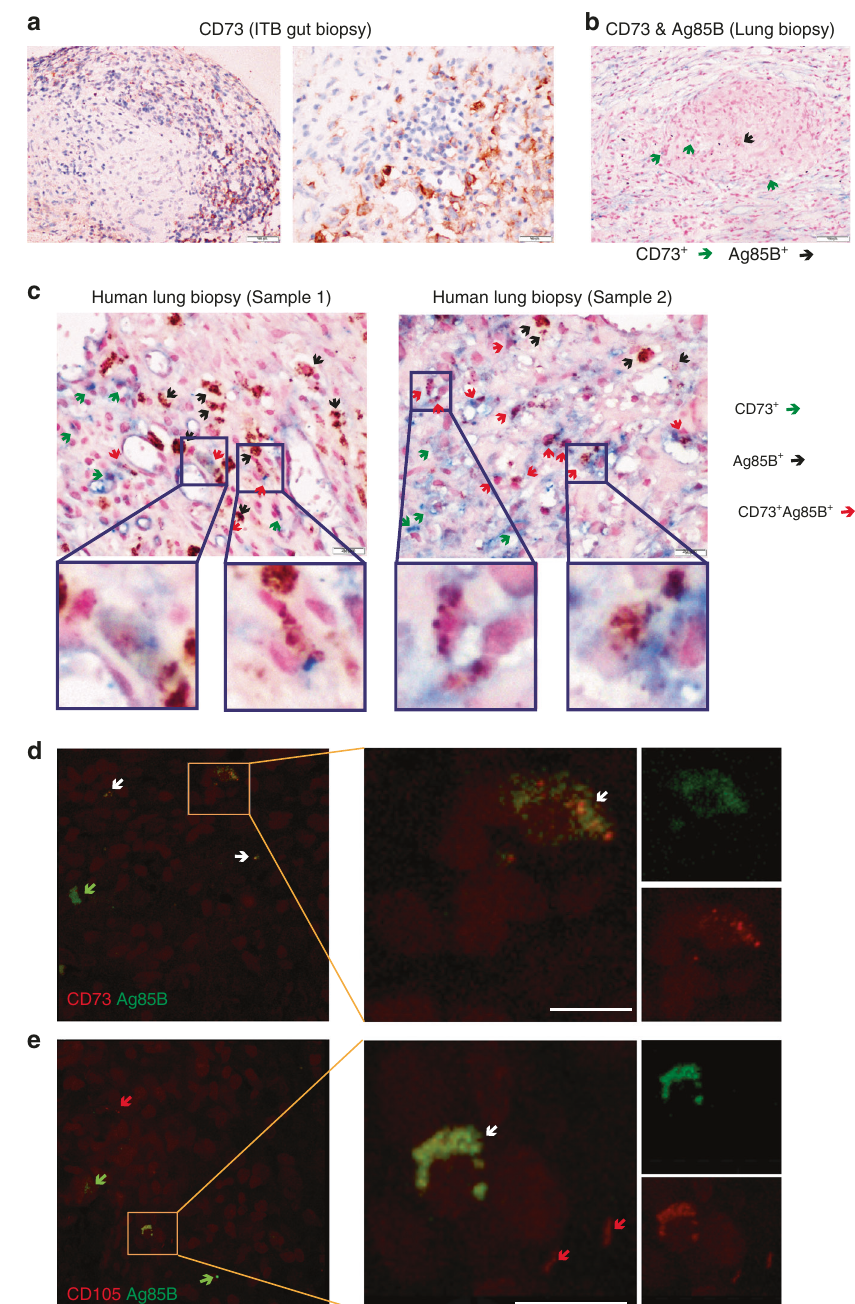
Fig. 5 Mtb co-localizes with MSC in human pulmonary and extra-pulmonary granulomas. a CD73 staining of biopsies from granuloma-positive intestinal tuberculosis patient, showing polarization of CD73-positive cells around the submucosal macrogranulomas [×100 (left panel, scale bar = 100 µ m), ×200 (Right panel, scale bar = 50 µ m)]. b CD73 and Ag85B dual staining performed on lung biopsy tissue from patients with pulmonary tuberculosis showing polarization of CD73 + cells (green arrows) toward the granulomas. Ag85B-positive organisms (black arrows) are seen inside the granulomas (×100, scale bar = 100 µ m). c Representative of two independent human lung biopsies, Ag85B-positive organisms (brown color) are seen inside the histiocytes (black arrows), CD73 + cells are stained with blue chromogen (green arrows) and the cells showing both positivity for CD73 + and Ag85B + organisms have been represented by red arrows (×400, scale bar = 20 µ m). Insets below show the corresponding magni fi ed CD73 + cells showing positivity of Ab85B staining. d Immuno fl uorescence staining performed on formalin- fi xed paraf fi n-embedded (FFPE) tissue of human lung biopsies from patients with known tuberculosis show green fl uorescence for Ag85B + (green arrows), red fl uorescence for CD73 + cells (red arrows) and colocalization signals are marked with white arrows. The strong colocalization area is shown in the yellow inset and magni fi ed in the panel at the right. In the further right panel, corresponding green and red channel fl uorescence is shown. Scale bar is 10 µ m. e FFPE tissue processed for dual IF staining show Ag85B + only (green arrows), CD105 + MSCs (red arrow) and cells positive for both CD105 and Ag85B (white arrow). The strong colocalization area is shown in the yellow inset and magni fi ed in the panel at the right. In the further right panel, corresponding green and red channel fl uorescence is shown. Scale bar is 10 µ m. Data shown in this fi gure are representative of seven independent